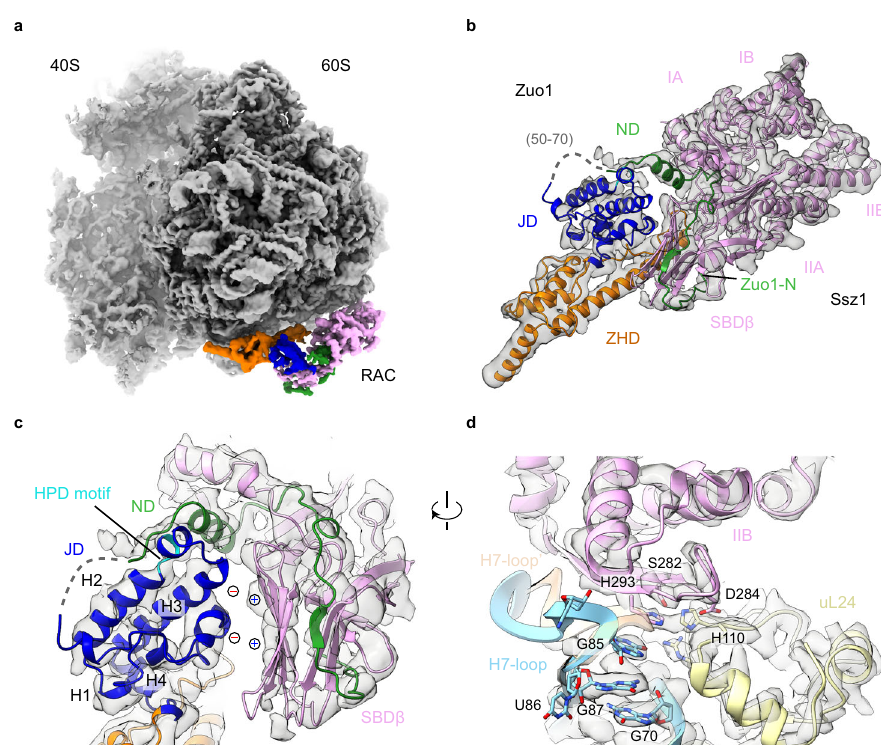
Fig. 4 Structure of the RNC-RAC complex with nearly full density of RAC. a Overall structure of the State C2 from the RNC-RAC dataset. The density map is from Map 3.5 in Supplementary Fig. 9. The ribosome is colored gray, and Zuo1 ND, JD, ZHD and Ssz1 are shown in green, blue, orange and pink, respectively. b Segmented density map of RAC, superimposed with the models of Zuo1 and Ssz1. The subdomains of both proteins are labelled, and the fl exible sequence of Zuo1 (50 – 70) is indicated in a gray dash-line. The density map is from Map 3.6 in Supplementary Fig. 9. c Magni fi ed view of the intermolecular interface between Zuo1 JD and Ssz1 SBD. Zuo1 ND partially blocks the HPD motif (highlighted in cyan) of Zuo1 JD. The polar interface between the surface of Zuo1 JD helices and Ssz1 SBD is highlighted by circled “ + ” and “ - ” symbols. d Ribosomal contacts of Ssz1 at the PTE. Ssz1 interacts with uL24 and H7-loop, a component of the 25S rRNA, through its subdomain NBD-IIB. Ssz1 and uL24 are shown in pink and light yellow, respectively. H7- loop, with or without Ssz1 interactions, is colored light blue and apricot, respectively. Selected residues of Ssz1, uL24 and H7-loop are shown in stick models and